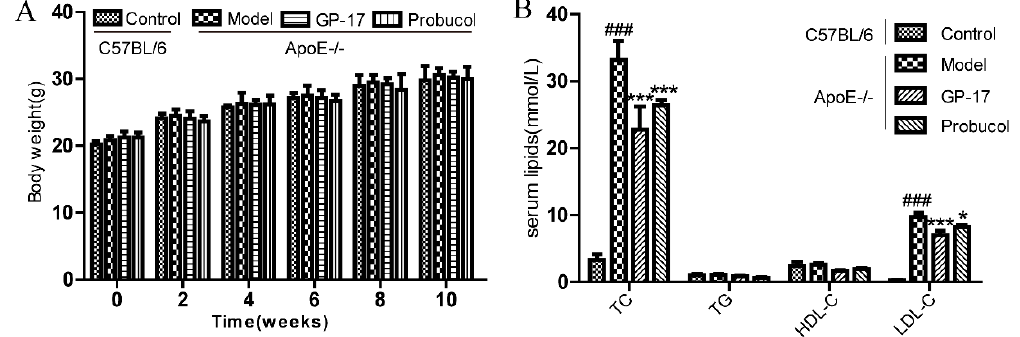
Figure 2. Effects of GP-17 on the body weights and serum lipids at 10 weeks in high fat diet-induced atherosclerotic ApoE − / − mice. ( A ) Changes in body weight after treatment; ( B ) The level of serum lipids. The values are expressed as the mean ± S.E.M. ( n = 8 for each group). ### p < 0.001 vs. Control; * p < 0.05; *** p < 0.01 vs. Model. TC, total cholesterol; TG, triglyceride; HDL-C, high-density lipoprotein cholesterol; LDC-C, low-density lipoprotein